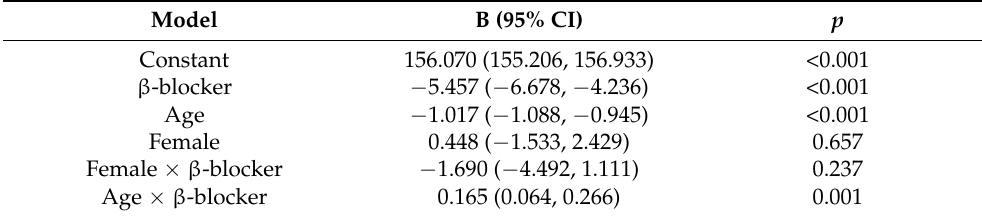
Table A2. Results of the linear regression model with maximum heart rate as the outcome.